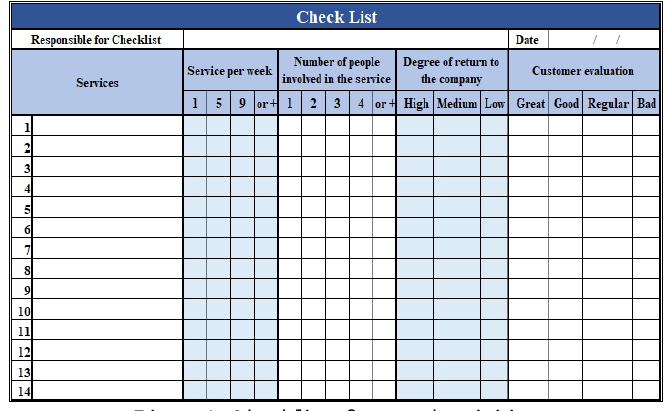
Figure 1: Checklist of mapped activities.